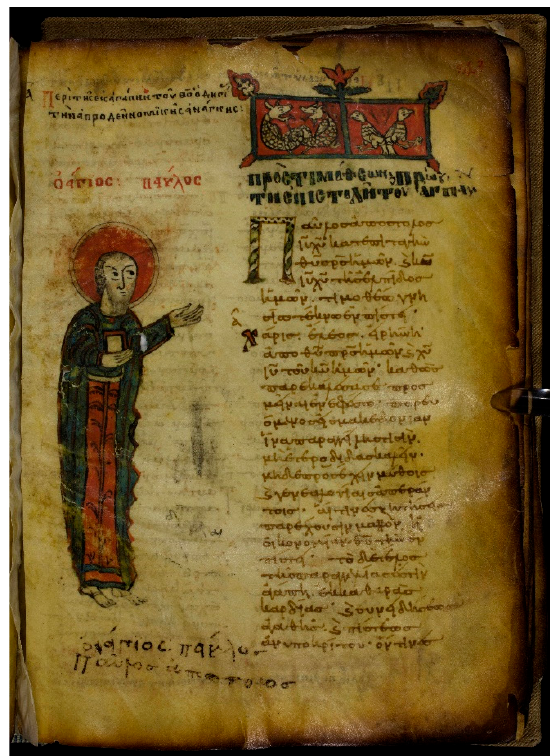
Figure 6. Miniature of the Apostle Paul. National Library of Greece. EBE 149, f. 143r (GA 1875). Ca. 10th century CE. Image used by permission from the National Library of Greece and the CSNTM.